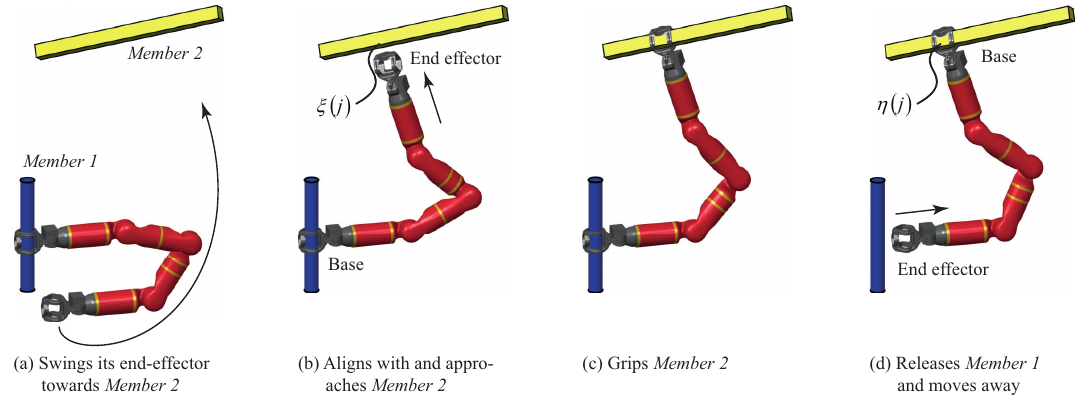
Figure 4. Procedures in the transition from Member 1 to Member 2 , illustrated with